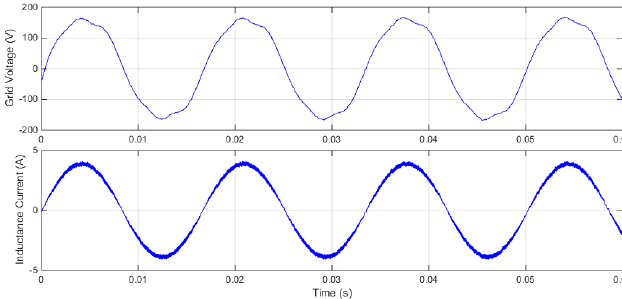
Fig. 9. Output voltage and output current when L g = 19.5 mH ( k p = 2)